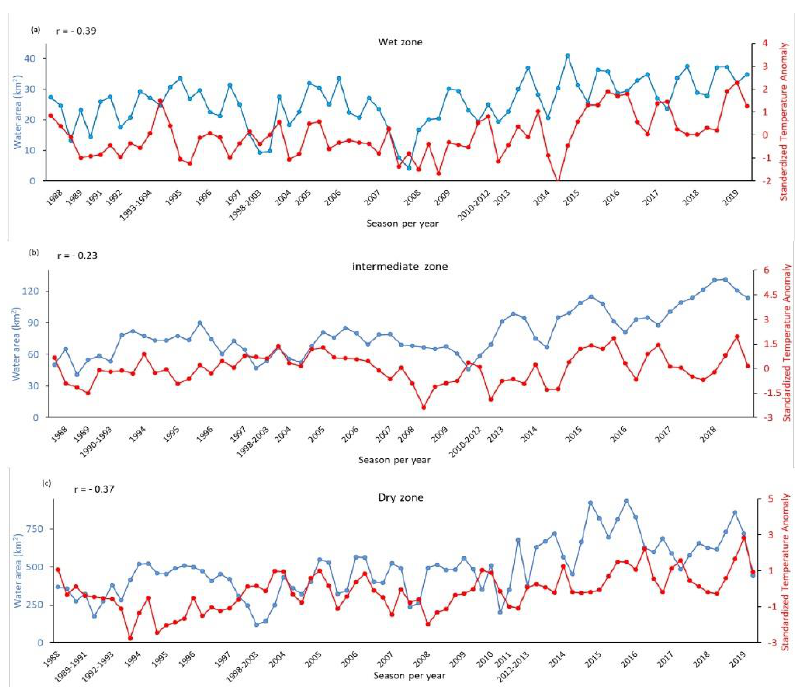
Figure 11. Time-series of seasonal standardized temperature anomaly index and water area and in different zones: ( a ) Wet zone, ( b ) Intermediate zone, and ( c ) Dry zone.